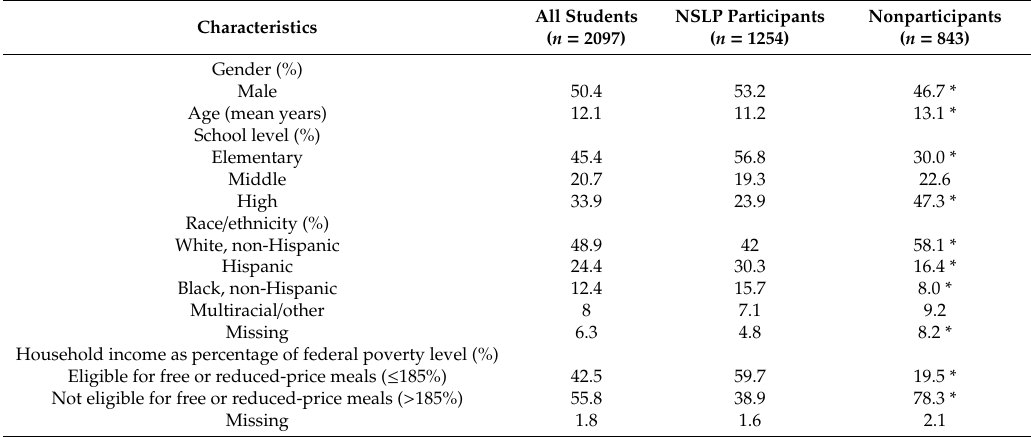
Table 2. Sociodemographic characteristics of students, by National School Lunch Program (NSLP) participation